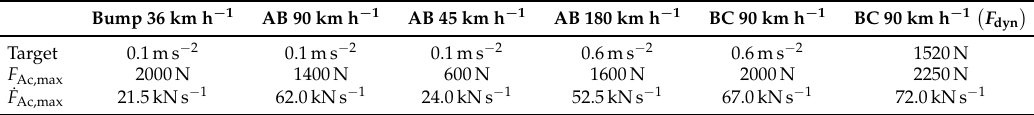
Table A2. Optimal actuator limits for the chosen target